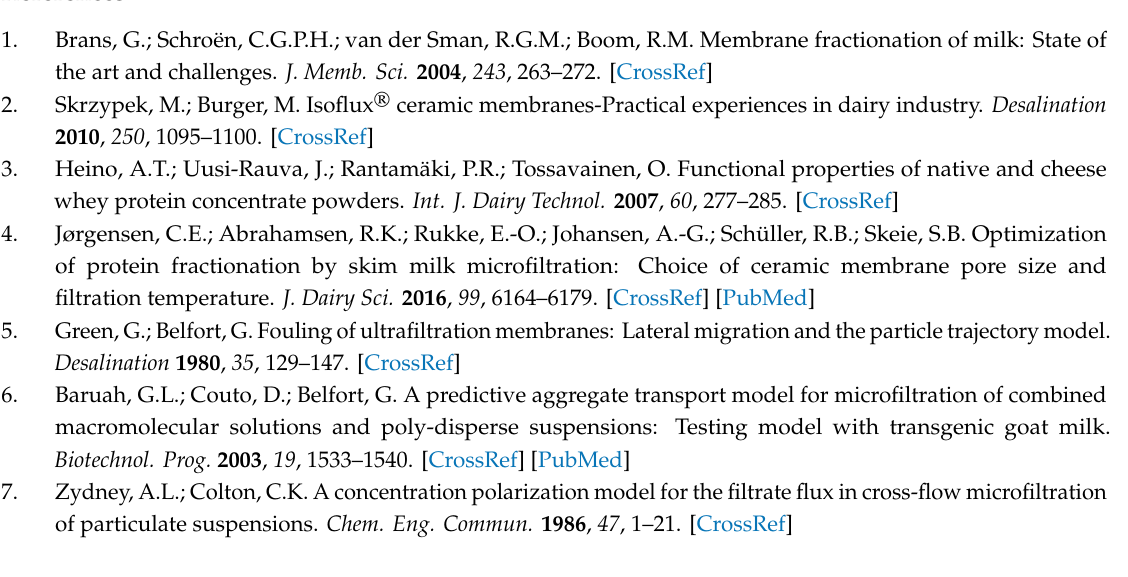
Figure S1: Evolution of the percentage of proteins respect their original concentration under extreme shear stress conditions: 231 Pa at 40 ◦ C, and shear stress of 214 Pa at 60 ◦ C, Table S1: Properties and Reynolds number for w á ter, Table S2: Experimental runs and results for JL according to Box Behnken design for the 2 mm dh membrane, Table S3: Experimental runs and results for JL according to Box Behnken design for the 3.6 mm dh membrane and additional runs, Table S4: Experimental runs and results for JL according to Box Behnken design for the 6 mm dh membrane and additional